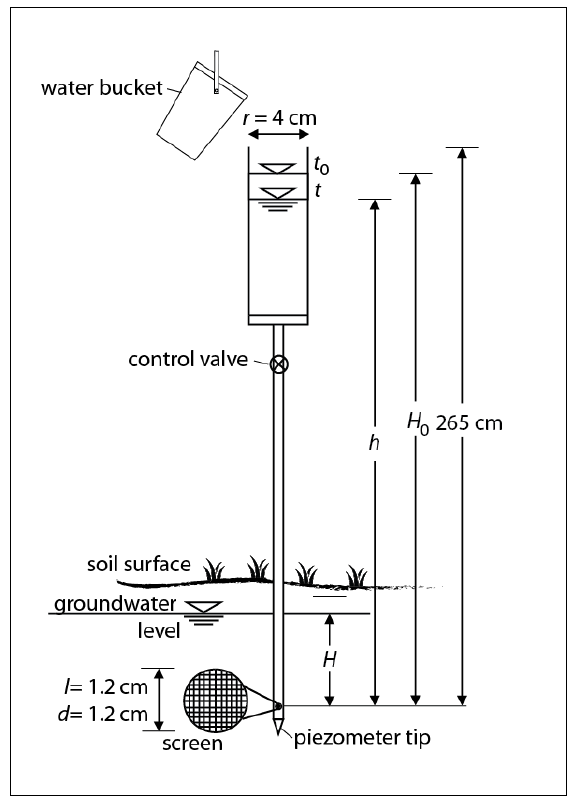
Figure 2. A schematic diagram of a direct-push piezometer with falling head (adapted from Ronkanen & Klove, 2005). Height from the centre of the outlet screen = 265 cm; r (inner radius of the reservoir) = 4.0 cm; length and diameter of the outlet screen = 1.2 cm; H = water level from outflow point of piezometer; H 0 = the initial water level in the reservoir, h = water level in the container at a time point t . The tip of the device is sharp and connected smoothly to the body of the device to avoid compression of soil when inserting into the